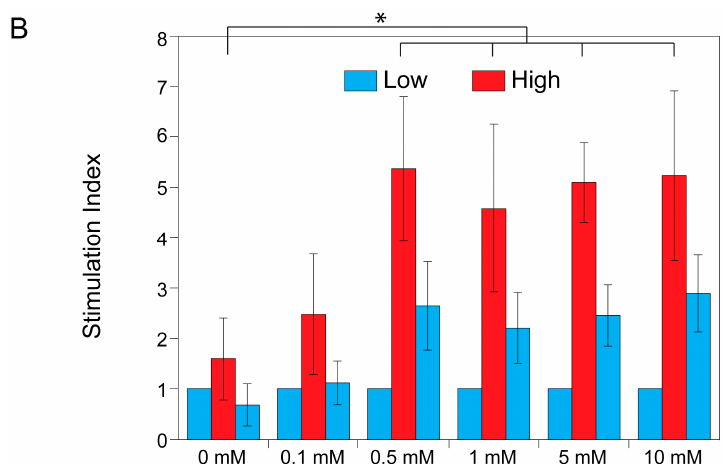
Figure 4. Theophylline concentration – dependent insulin secretion of INS1E pseudo-islets. Dose-response results of the glucose-induced insulin secretion test of INS1E pseudo-islets at different concentrations of theophylline. ( A ) Secreted amount of insulin (µg/L) is shown; ( B ) Data are normalized by the amount of insulin secreted in low glucose condition (stimulation index). Data are expressed as mean ± standard deviation and significant differences are indicated with * ( p ≤ 0.05).